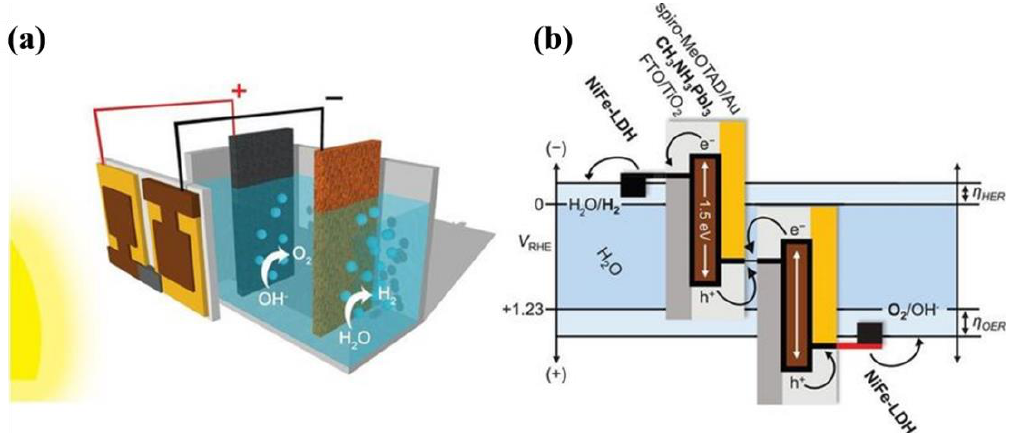
Figure 11. Combination of the perovskite tandem cell with NiFe DLH/Ni foam electrodes for water splitting, ( a ) Schematic diagram of the water-splitting device, ( b ) A generalized energy schematic of the perovskite tandem cell for water splitting [211]. Copyright from 2014, American Association for the Advancement of Science.